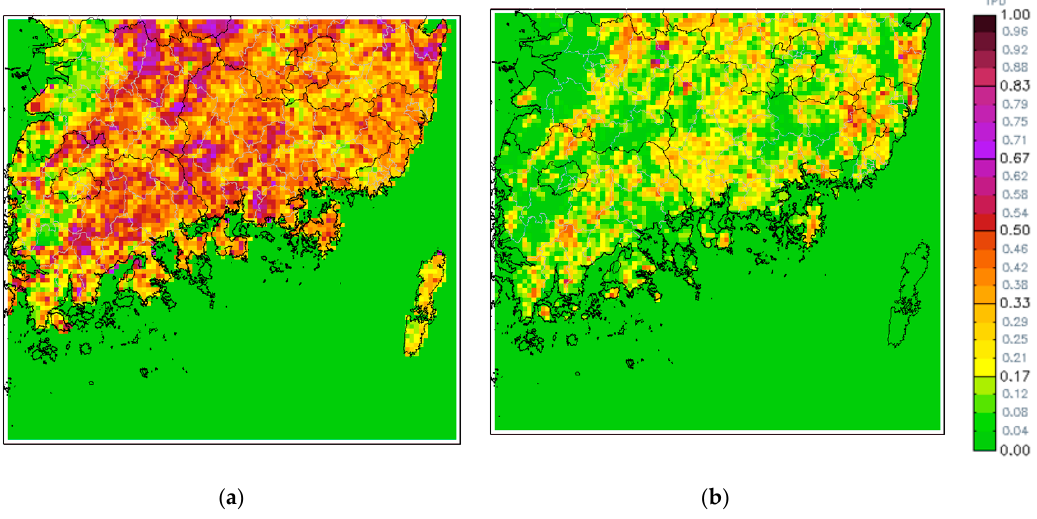
Figure 5. Period average isoprene emissions modeled by ( a ) MEGAN and ( b ) BEIS3 in tons per day (TPD). MEGAN: Model of Emissions of Gases and Aerosols from Nature; BEIS3: Biogenic Emissions Inventory System Version 3.